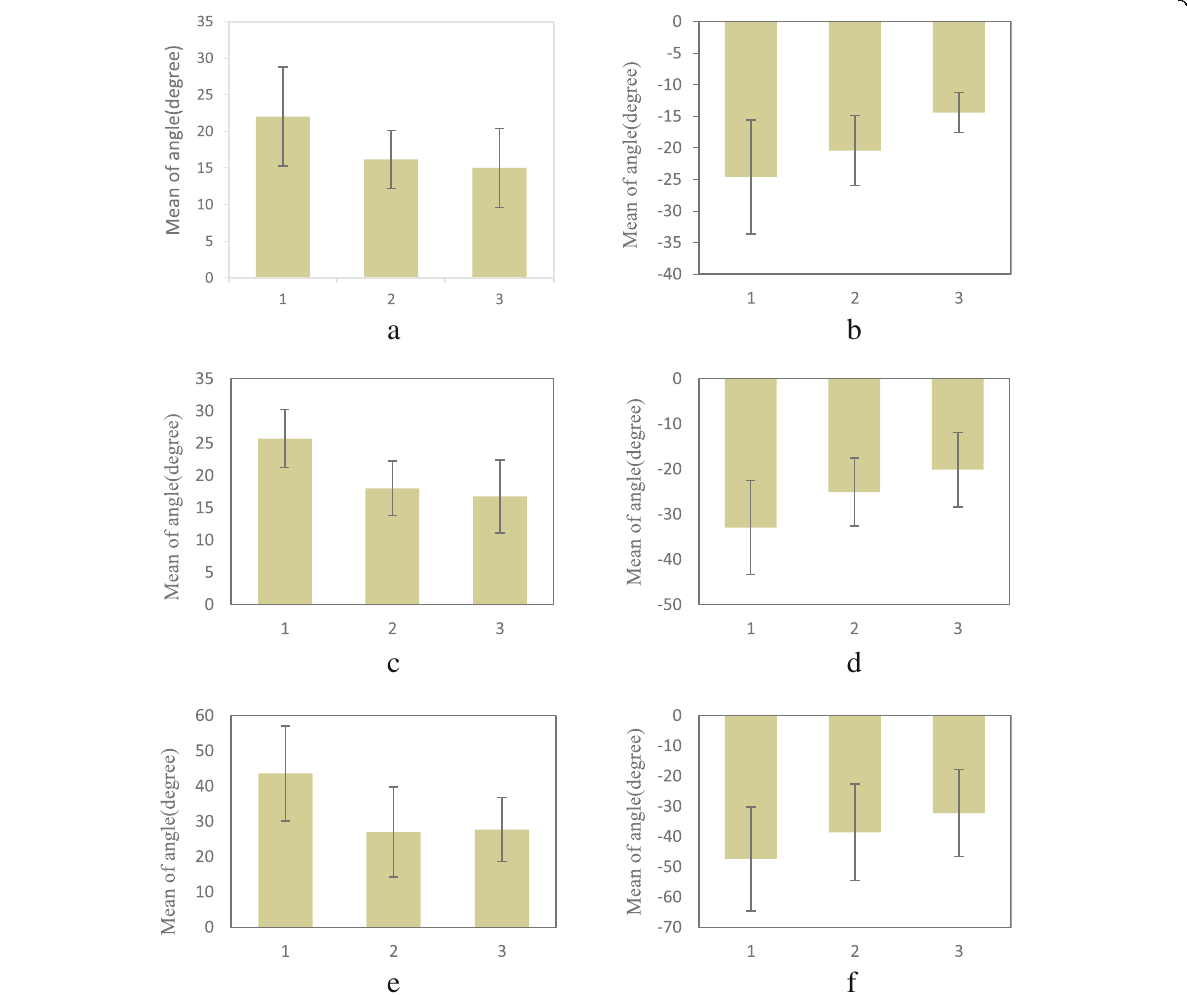
Fig. 10 Bar charts of the range of motion with three grades of restoring force (95% CI). a In the X -axis positive direction. b In the X -axis negative direction. c In the Y -axis positive direction. d In the Y -axis negative direction. e In the Z -axis positive direction. f In the Z-axis negative